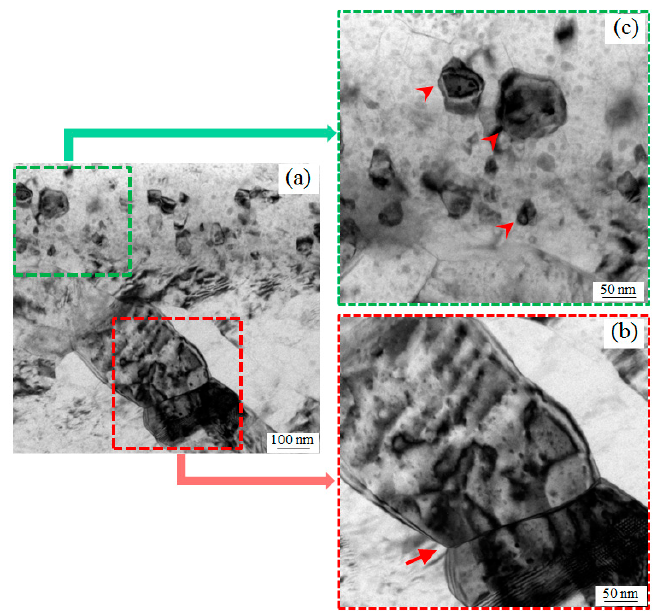
Figure 8. TEM (Transmission Electron Microscopy) images of the DSR-deformed 6061 Al alloy plates annealed at 225 °C for 1 h: ( a ) general microstructure; ( b ) pinching-off of the lamellar HAGBs (high-angle grain boundaries) formed after DSR deformation and subdivision of the elongated grains into shorter segments; ( c ) evolution of fine recrystallized grains.